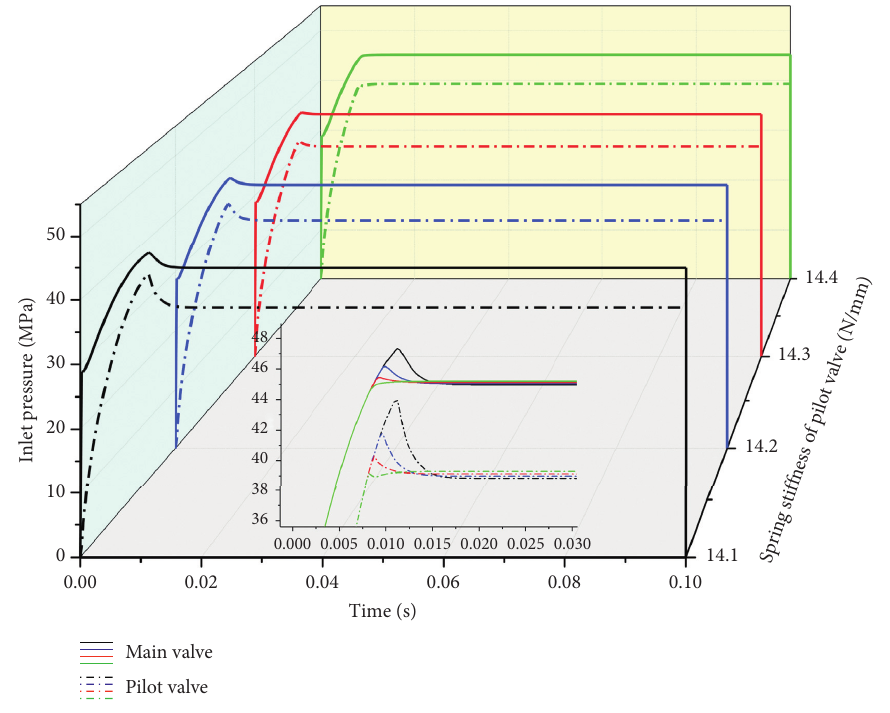
Figure 8: Influence of pilot valve spring on pressure.